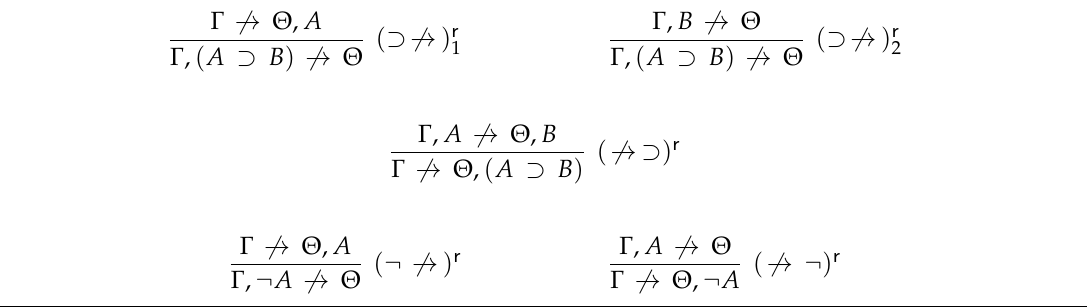
Figure 6. Rules of the anti-sequent calculus LK r